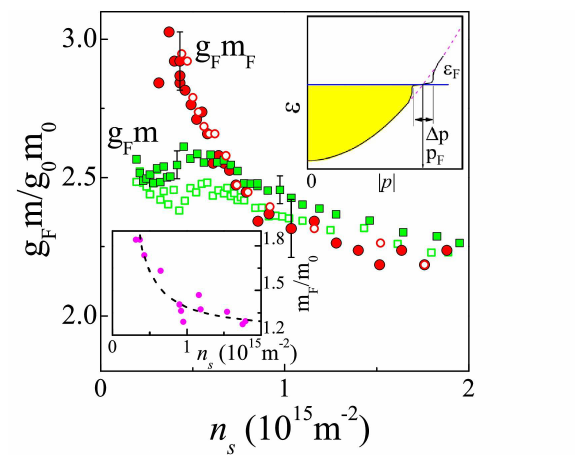
Figure 5. Product of the Landé factor and effective mass as a function of electron density in a SiGe/Si/SiGe quantum well determined by measurements of the field of full spin polarization B ∗ (squares) and Shubnikov–de Haas oscillations (circles) at T ≈ 30 mK. The empty and filled symbols correspond to two samples. The experimental uncertainty corresponds to the data dispersion and is about 2% for the squares and about 4% for the circles ( g 0 = 2 and m 0 = 0.19 m e are the values for non-interacting electrons; m e is the free electron mass; and g F ≈ g 0 is the g -factor at the Fermi level). The top inset shows schematically the single-particle spectrum of the electron system in a state preceding the band flattening at the Fermi level (solid black line). The dashed violet line corresponds to an ordinary parabolic spectrum. The occupied electron states at T = 0 are indicated by the shaded area. Bottom inset: the effective mass m F versus electron density determined by analysis of the temperature dependence of the amplitude of Shubnikov–de Haas oscillations, similar to [45]. The dashed line is a guide to the eye. From